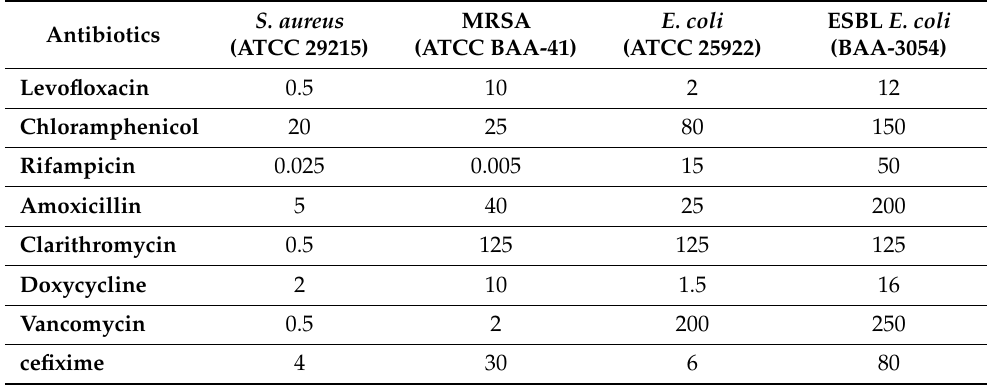
Table 3. Minimum inhibitory concentrations in µ M of the eight antibiotics against the tested bacte- rial strains.